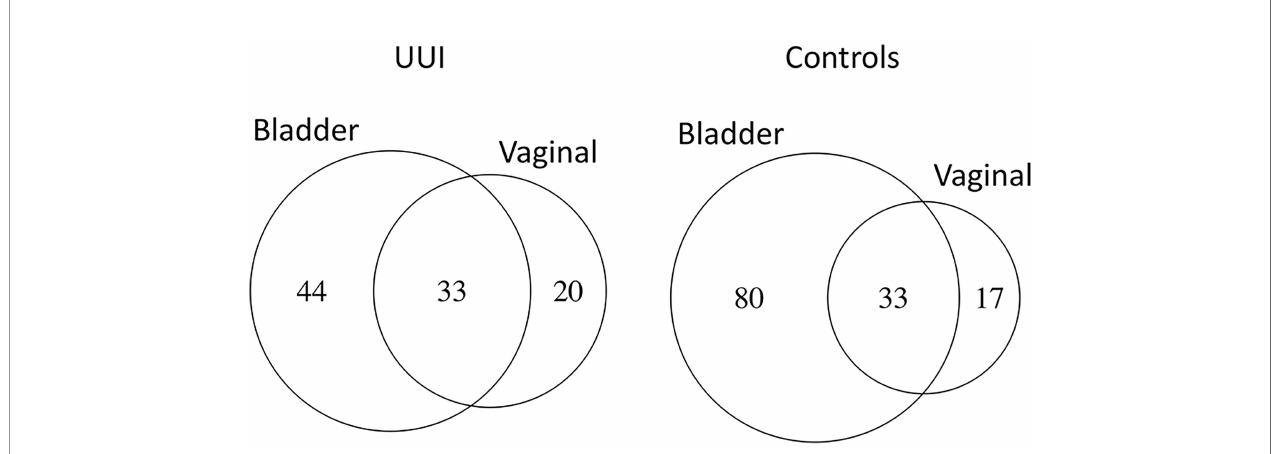
FIGURE 5 | The number of shared bacterial genera between vaginal and bladder microbiomes of women with UUI differ from women without UUI. Women without UUI (controls) have more unique bacteria in the bladder